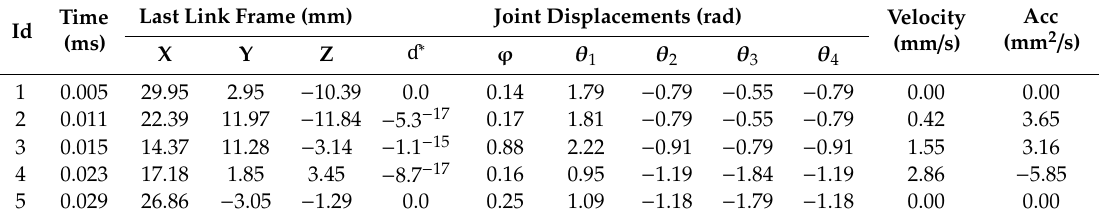
Figure 9. Motion profiles of the robot: ( a – c ) trajectory results for the three cases and ( d ) the trajectory error. Table 2. Parametric description of the robot for motion case 3.